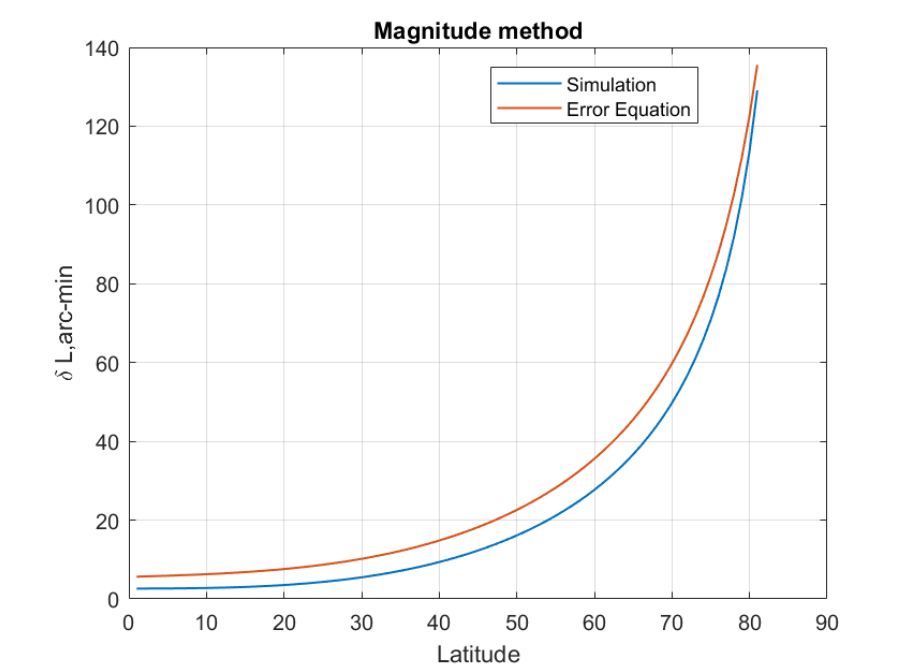
Figure 6. The latitude error of the magnitude method with latitude increasing.